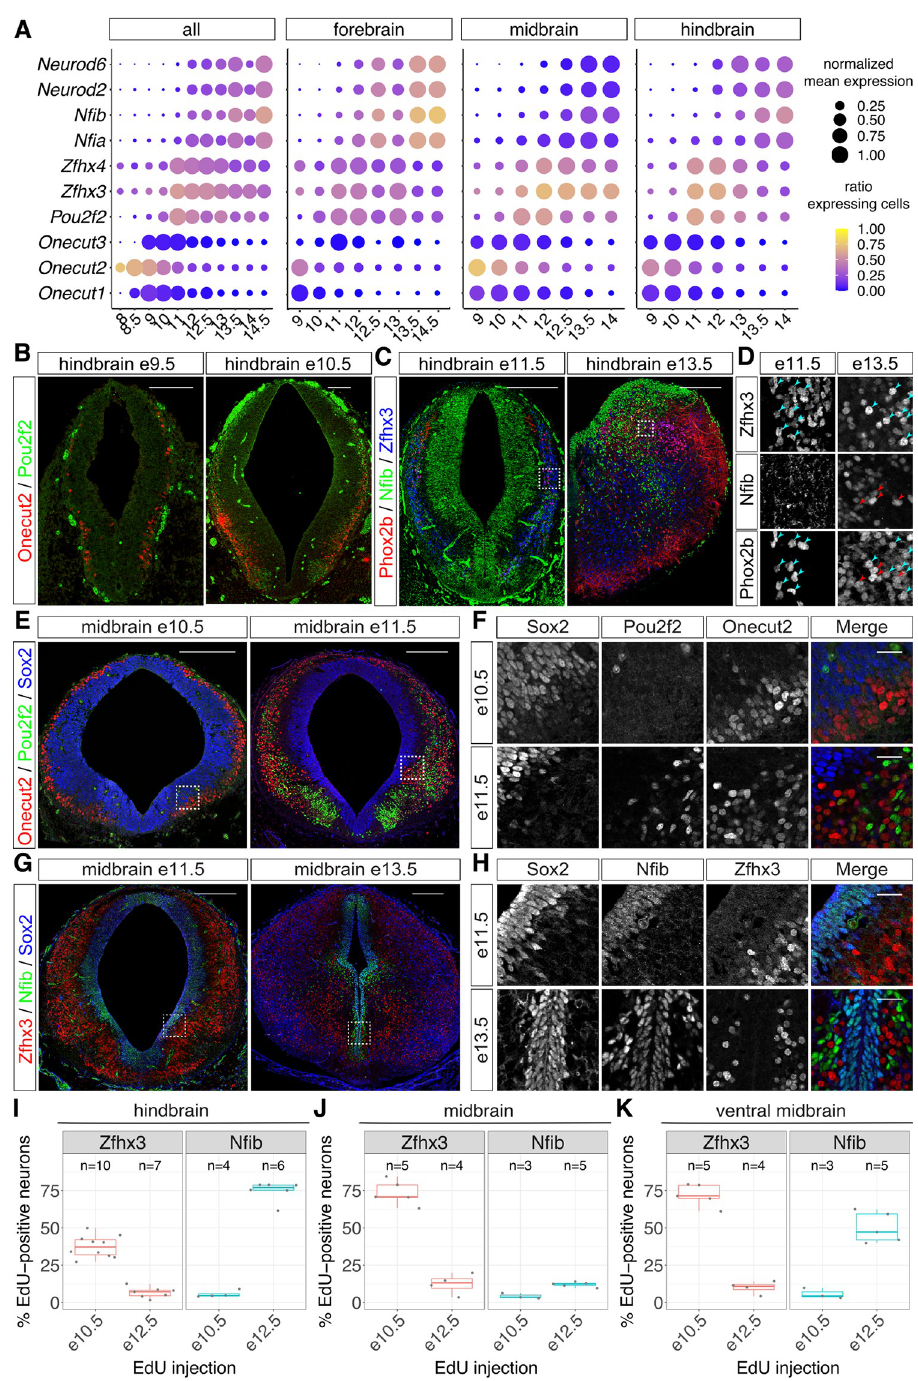
Fig 2. The temporal TF code is conserved at different rostral–caudal levels of the nervous system (see also S3–S9 Figs). (A) Expression of temporal TFs in scRNAseq data [9] from the developing forebrain, midbrain, and hindbrain suggests conservation of temporal patterning in these parts of the nervous system. (B-D) Conservation of temporal patterning in the hindbrain. (B) Onecut2, but not Pou2f2, is expressed in hindbrain neurons at e9.5, while both TFs label distinct populations of neurons at e10.5. (C) Zfhx3, but not Nfib, labels neurons at e11.5. These TFs label distinct populations of neurons at e13.5. (D) Zfhx3 and Nfib label distinct subsets of Phox2b-positive neurons in the hindbrain at e13.5. (E-H) Conservation of temporal patterning in the midbrain. (F, H) show higher magnification images of the regions outlined in (E, G), respectively. (E, F) Onecut2, but not Pou2f2, labels neurons in the midbrain at e10.5.